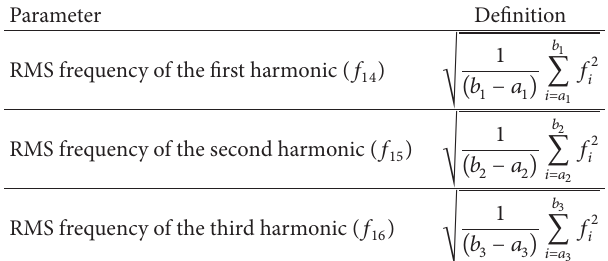
Table 3: Envelope spectrum statistical feature